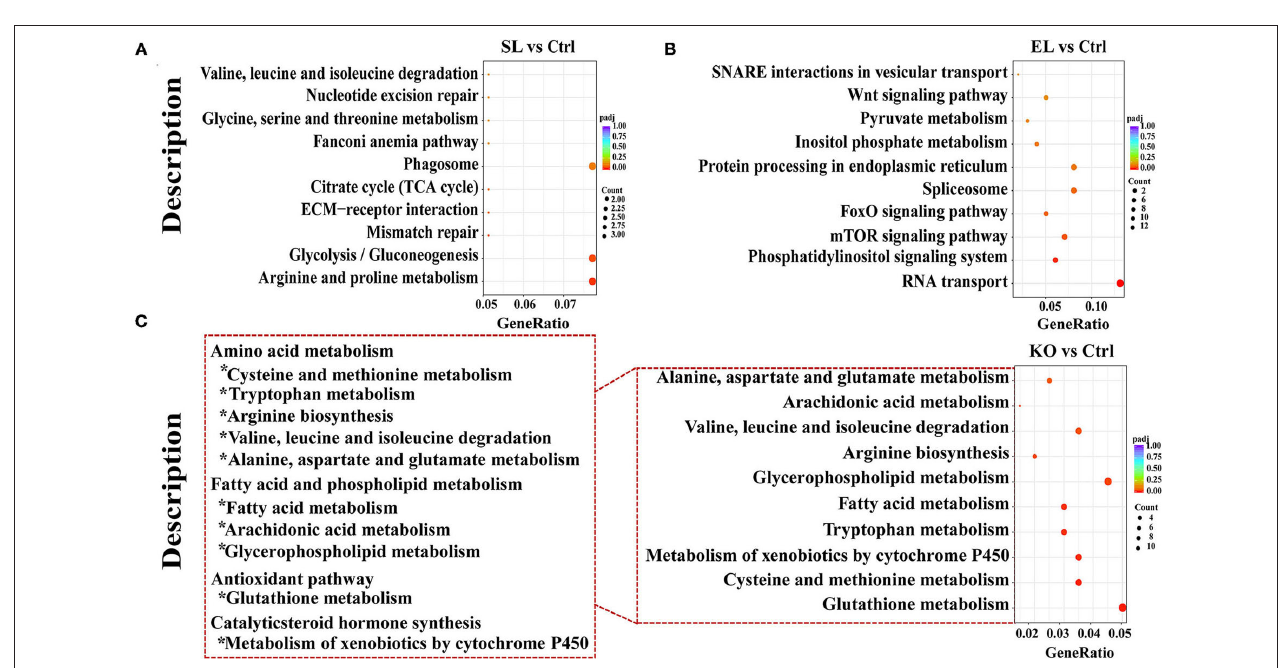
FIGURE 9 | The KEGG pathway analysis of differentially expressed genes. Pathway enrichment analysis plots (top 10) of upregulated differentially expressed genes. (A) Top 10 enrichment pathways in SL. (B) Top 10 enrichment pathways in EL. (C) Top 10 enrichment pathways in krill oil. P-adjusted < 0.05 was regarded as a significant enrichment in the relevant term. The gene ratio represents the ratio of the number of differentially expressed genes related to a pathway to the total number of differentially expressed genes. Ctrl (control, phospholipid-devoid), SL (added 4% soybean lecithin), EL (added 4% egg yolk lecithin), and KO (added 4% krill oil).